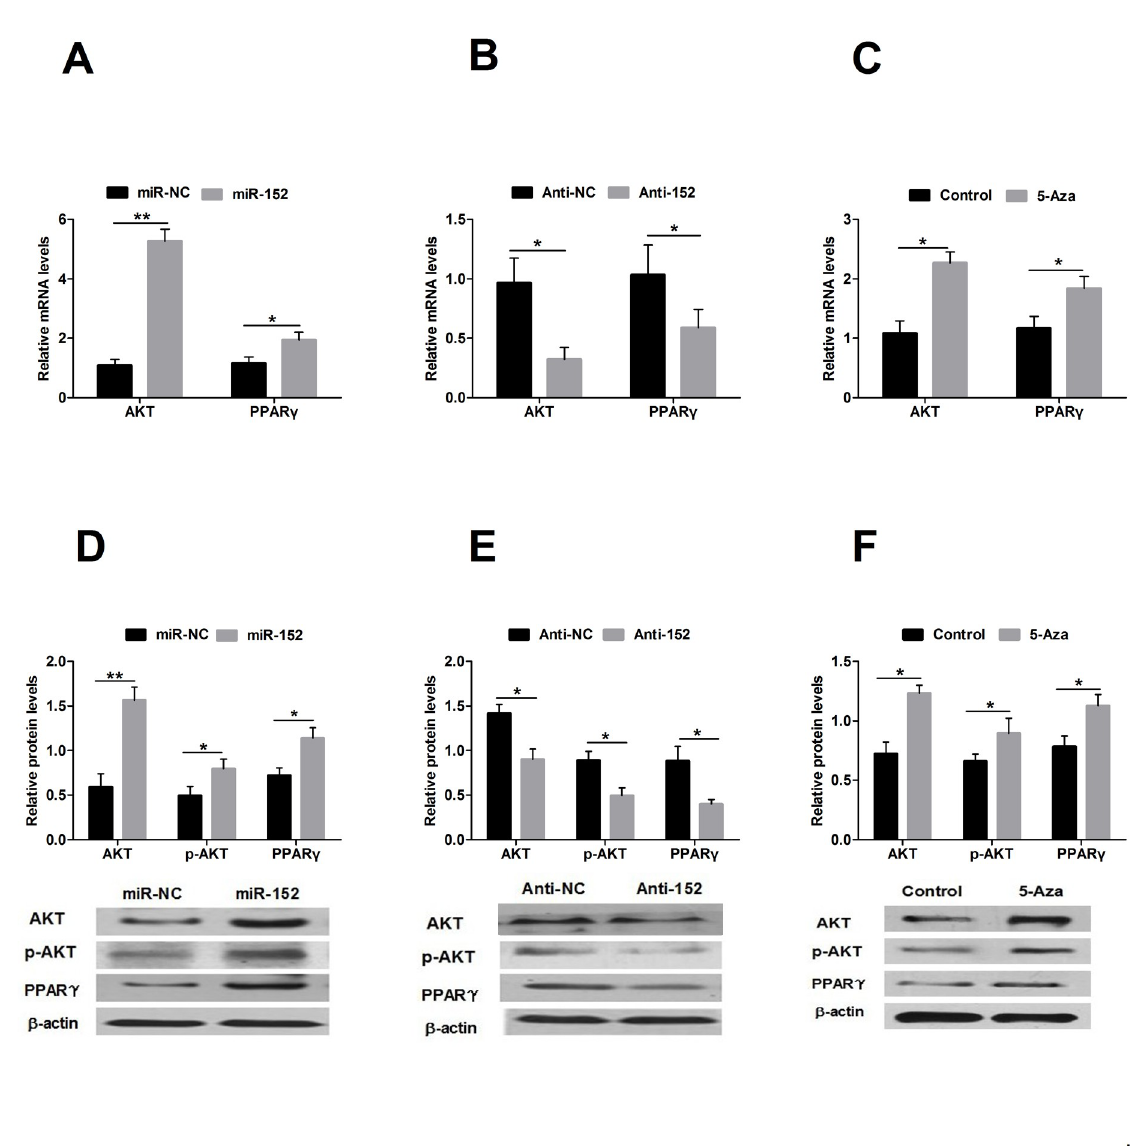
Fig 5. Expression of AKT and PPAR γ during miR-152 over-expression and inhibition in DCMECs. A: mRNA levels of Akt and Ppar γ following transfection of DCMECs with miR-152 and miR-NC; B: mRNA levels of Akt and Ppar γ following transfection of DCMECs with Anti-152 and Anti-NC; C: mRNA levels of Akt and Ppar γ following treatment with 5-Aza; D: Protein levels of AKT, p-AKT and PPAR γ following transfection of DCMECs with miR-152 and miR-NC; E: Protein levels of AKT, p-AKT and PPAR γ following transfection of DCMECs with Anti-152 and Anti-NC; F: Protein levels of AKT, p-AKT and PPAR γ following treatment with 5-Aza. Expression levels are showed relative to the average expression of β -Actin . AKT and PPAR γ are markedly increased in cells transfected with miR-152 compared with cells transfected with miR-NC. Cells transfected with Anti-152 show the opposite results. AKT and PPAR γ are markedly higher in cells treated with 5-Aza than in control cells. Values are means ± SD, � P < 0.05, �� P < 0.01.